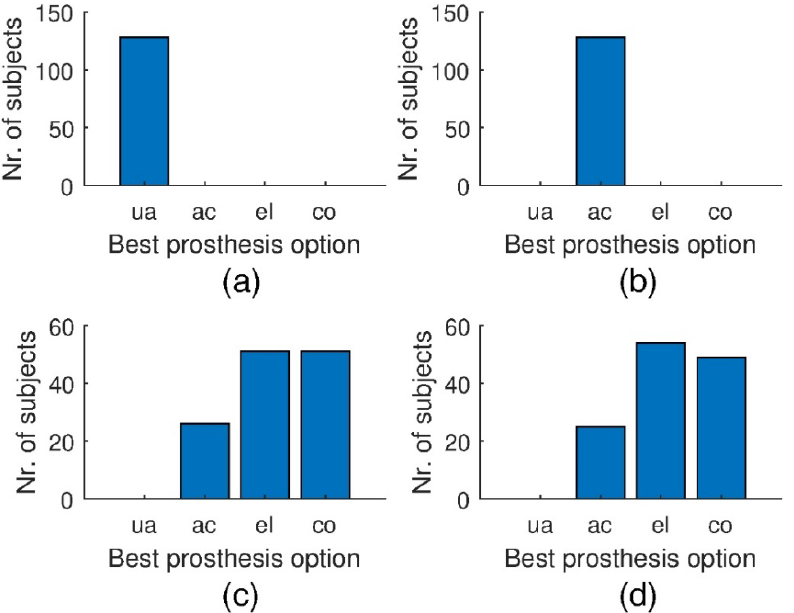
Figure 2. Numbers of subjects with regard to the individually predicted best hearing prosthesis, i.e., the prosthesis corresponding to the minimum cost-adjusted loss of action potentials (LAP) score. The types of hearing loss are as follows: ( a ) normal hearing (NH), ( b ) cochlear gain loss (CGL), ( c ) loss of IHCs (IHCL), ( d ) IHCL + CGL. The types of hearing prosthesis are as follows: unaided hearing (ua), acoustical amplification (ac), electrical stimulation (el), and el combined with ac (co).